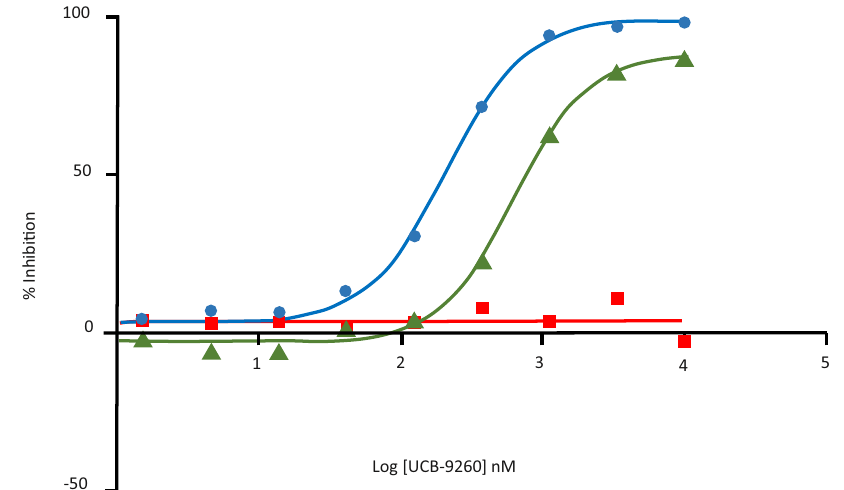
Fig. 5 Inhibition of TNF signalling in cells. Representative concentration – response curves showing the effect of UCB-9260 on signalling in an NF κβ reporter cell assay driven by 10 pM hTNF (blue trace), 100pM hTNF (green trace) and anti-TNFR1 antibody at 300 ng/mL (red trace). Source data are provided as a Source Data fi